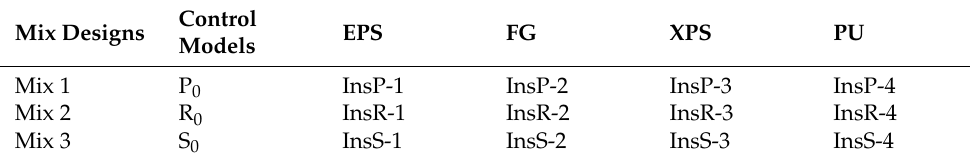
Table 3. Building Component Optimization Matrix (A ij